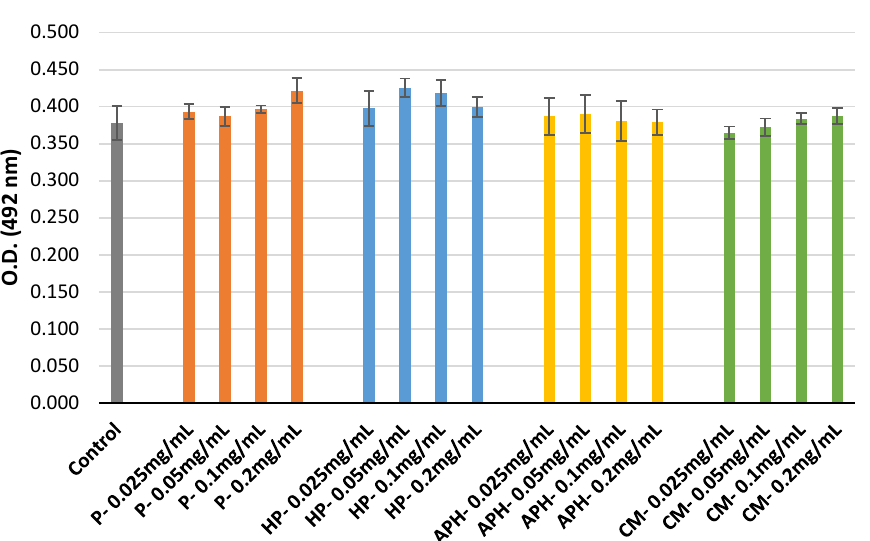
Figure 5. Cellular toxicity of P (water-soluble extract of pasteurized minced meat of BSFL), HP (water-soluble extract of hydrolyzed and pasteurized minced meat of BSFL), APH (hydrolysate of water-soluble BSFL proteins), and CM (water-soluble extract of chicken meal). Results expressed as mean ± standard deviation (n =